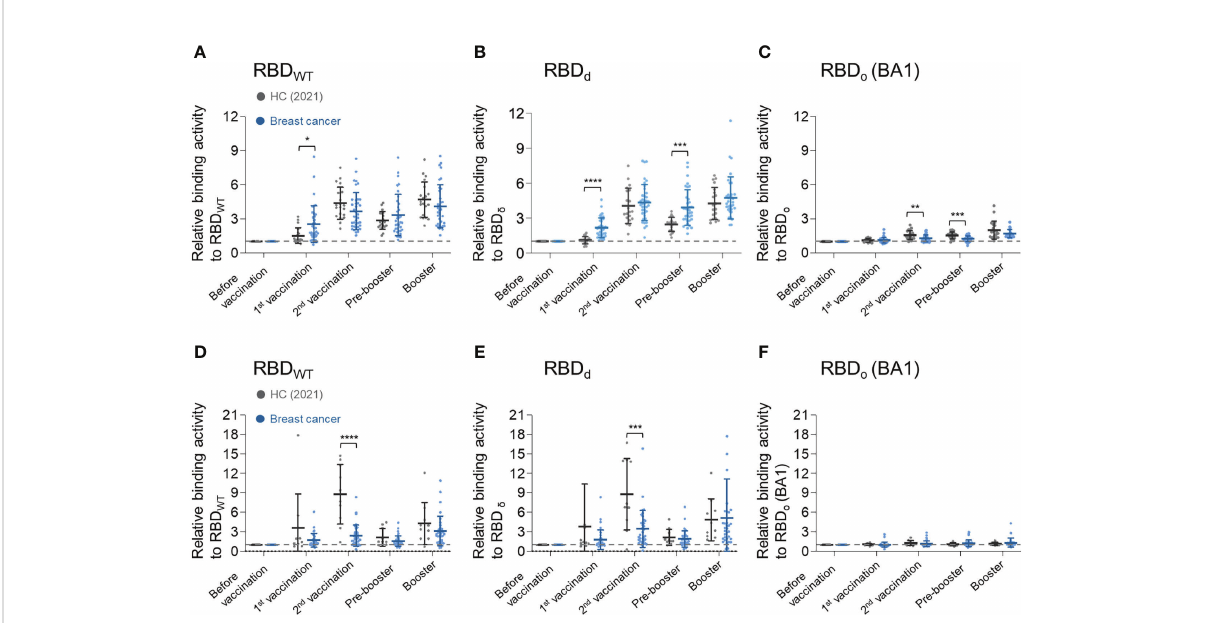
FIGURE 3 Longitudinal humoral immune response analysis to SARS-CoV-2 vaccine for SARS-CoV-2 VOCs. (A – C) Serum IgG binding activities against (A) RBD wt , (B) RBD d , and (C) RBD ο . (D – F) Serum IgA binding activities against (D) RBD wt , (E) RBD d , and (F) RBD ο . Binding activities of serum antibodies to RBD of SARS-CoV-2 variants were determined using anti-IgG or anti-IgA antibodies. In PBS, diluted plasma samples (1:100) were incubated with each biotinylated SARS-CoV-2 antigen and then detected by streptavidin-HRP. Statistical analyses were performed using the Multiple unpaired T-test in GraphPad Prism (* P < 0.05, ** P < 0.01, *** P < 0.001, **** P <